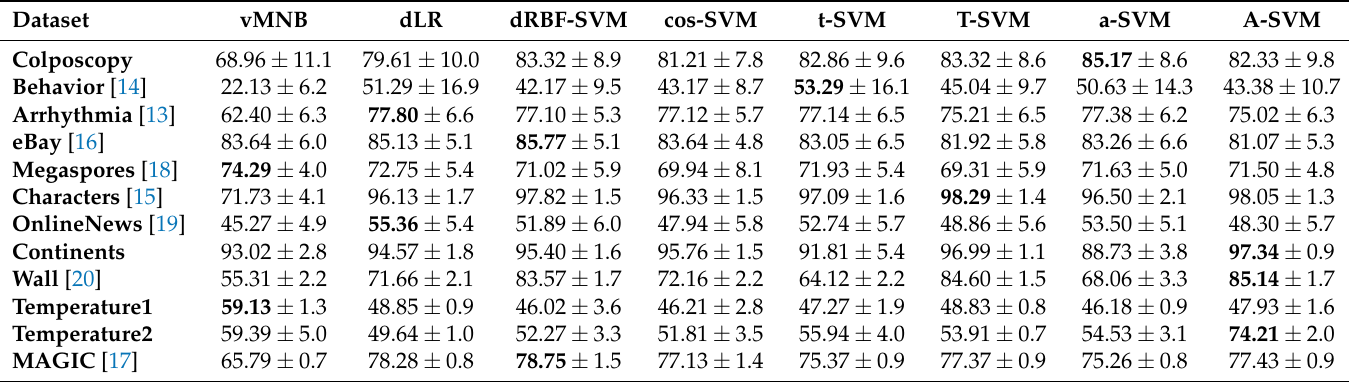
Table 2. Average macro F 1 -score and standard deviation in the same setting as described in Table 1. Best results are given in